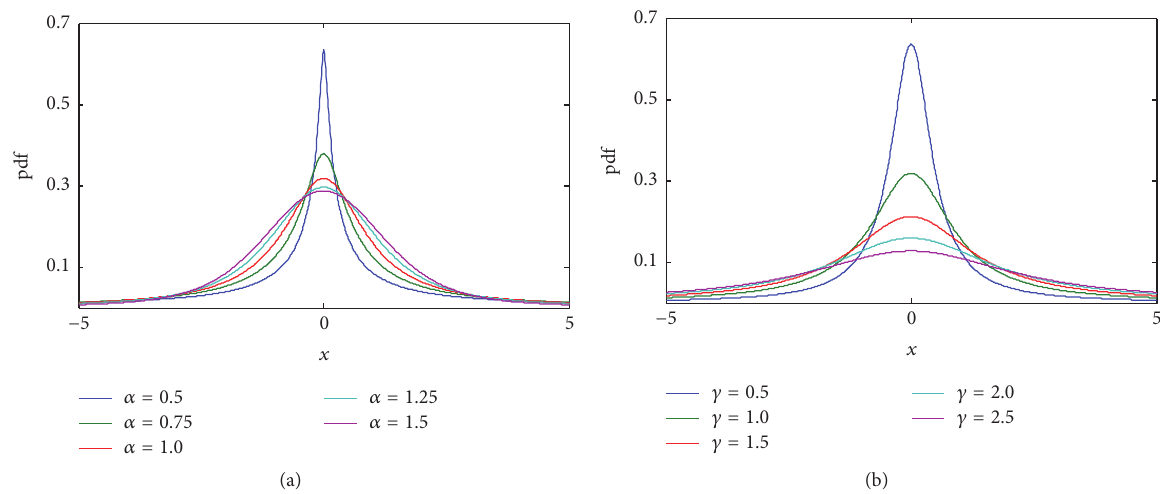
Figure 1: (a) The pdf of S 𝛼 S with different 𝛼 values; (b) the pdf of S 𝛼 S with different 𝛾 values.